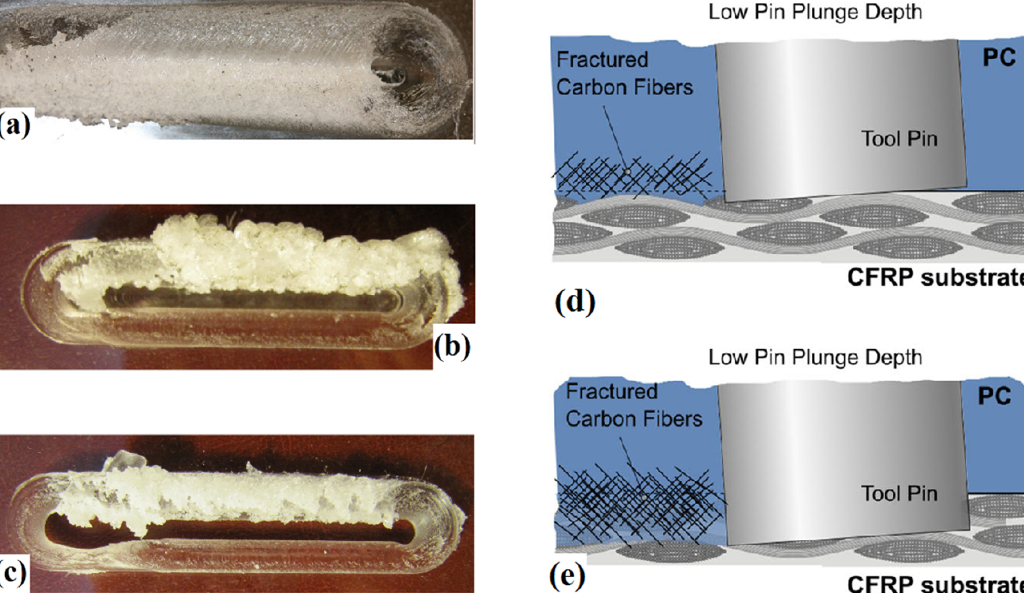
plunge depths of ( a ) 0.2, ( b ) 0.4, and ( c ) 0.6 mm [51]. Effects of ( d ) low tool plunge depth (TPD)